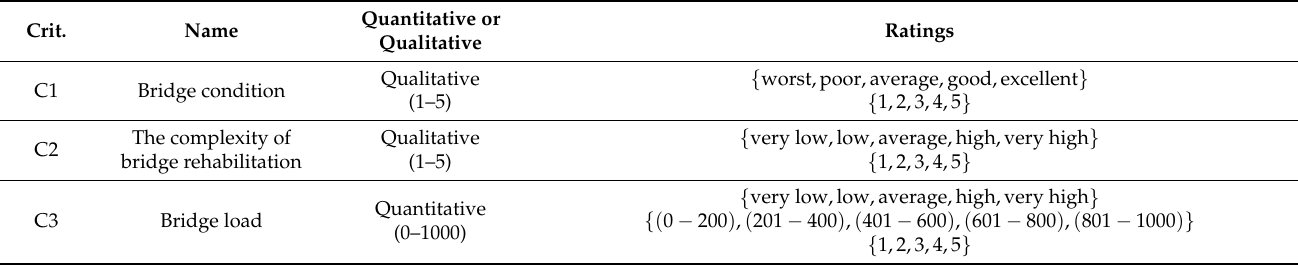
Table 3. Assessments of historic pedestrian bridges (linguistic values and numerical values in sets).